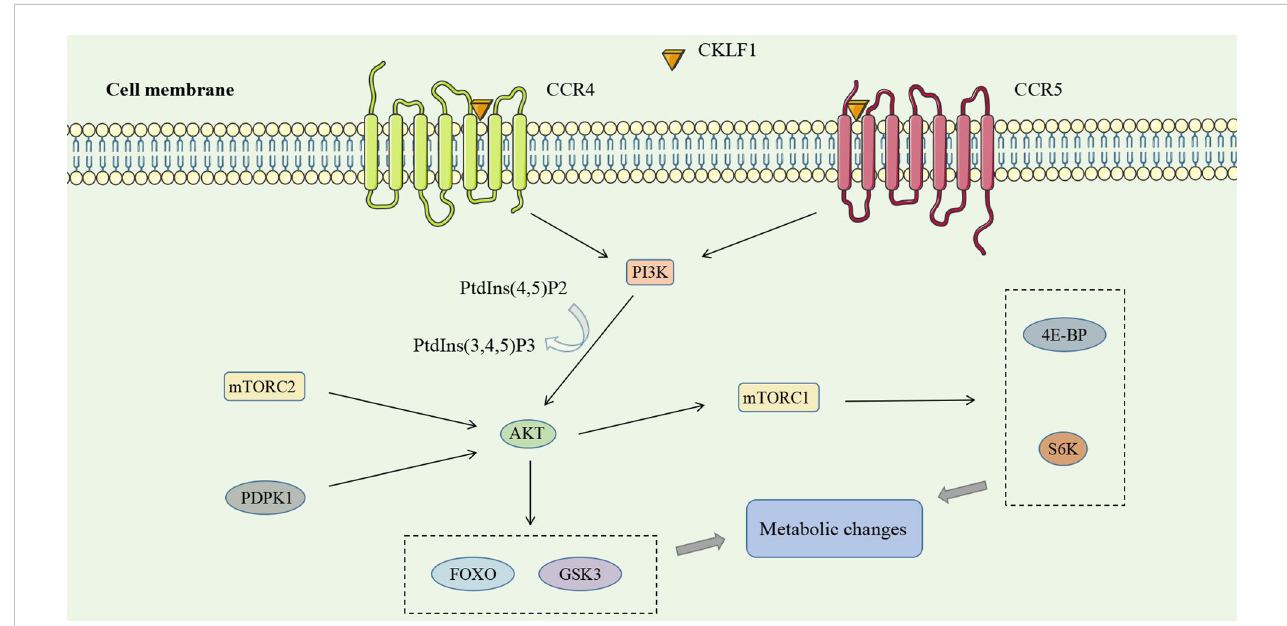
FIGURE 4 CKLF1 binds to both CCR4 and CCR5 and activates the PI3K/AKT signaling pathway, which plays a role in in fl ammatory injury through diverse downstream substrates of AKT and